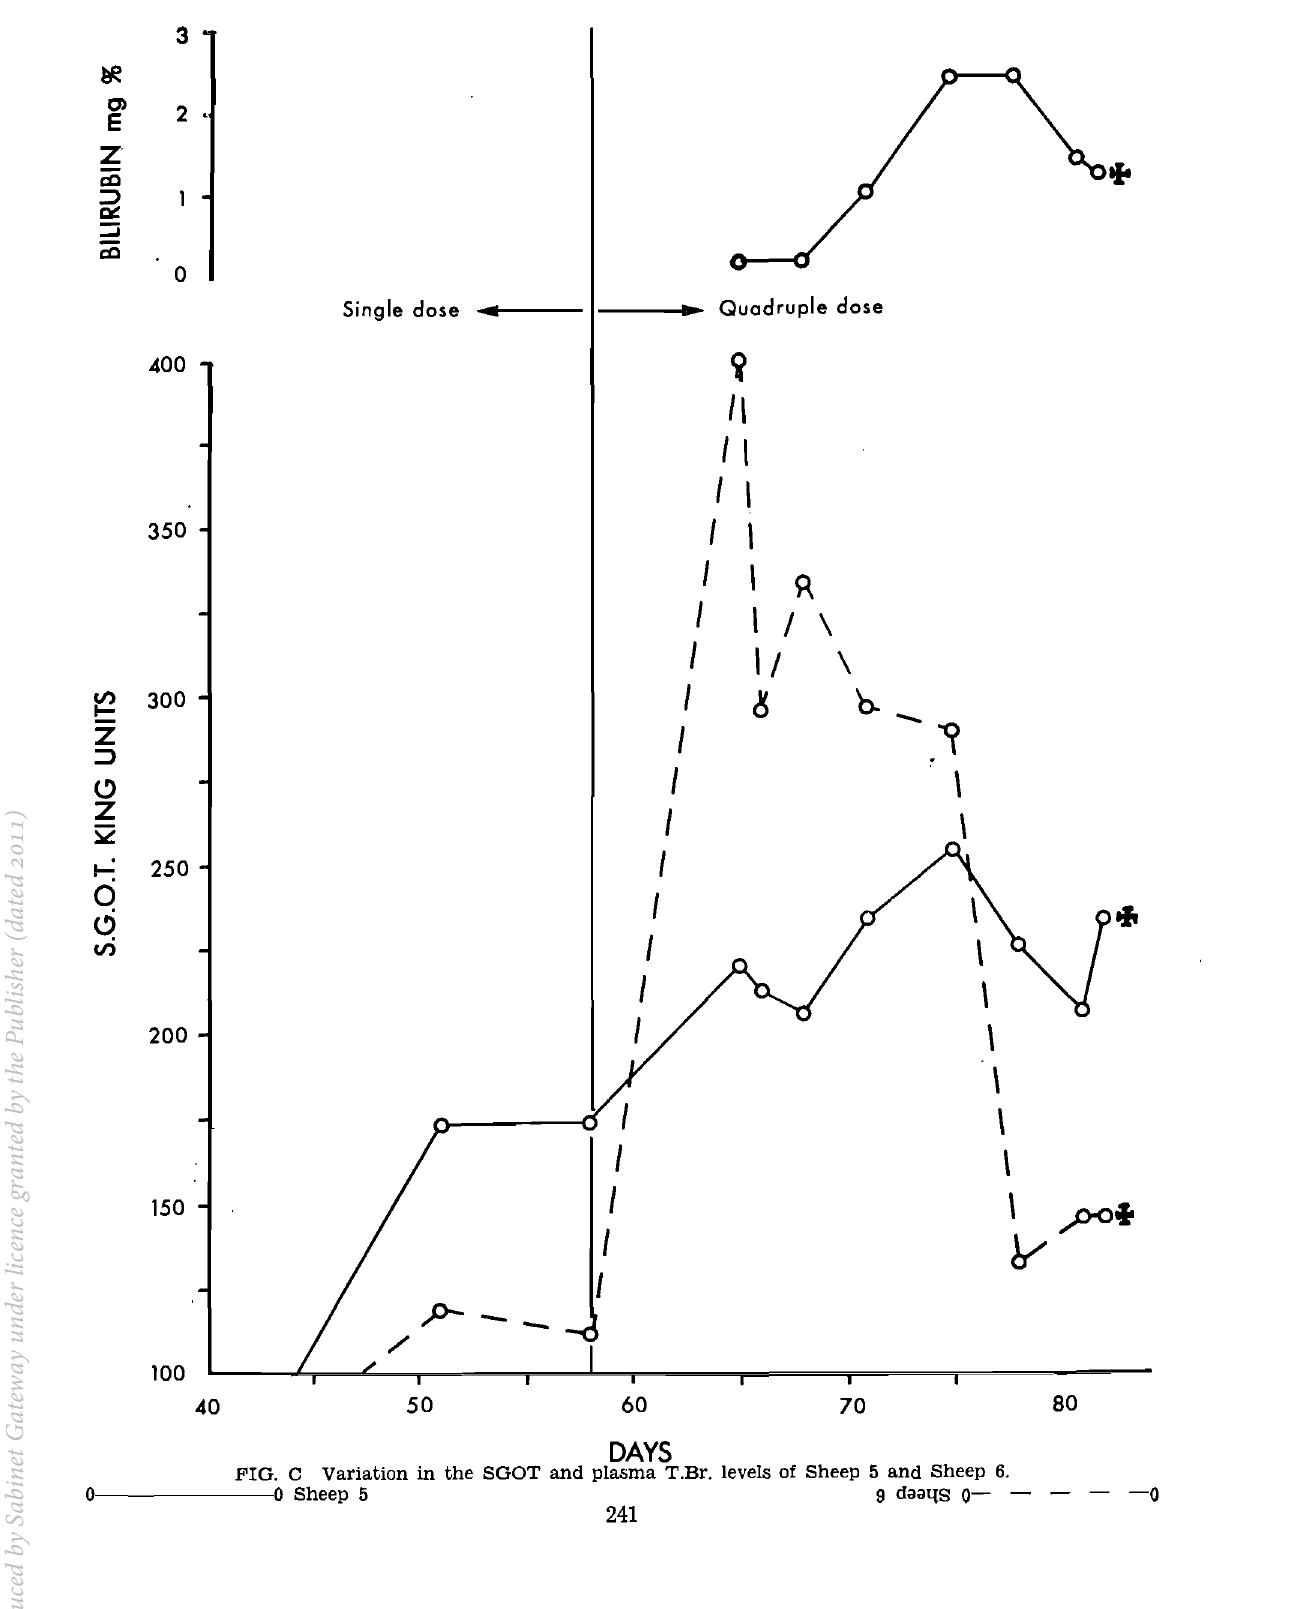
FIG. C Variation in the SGOT and plasma T.Br. levels of Sheep 5 and Sheep 6. 0 o Sheep